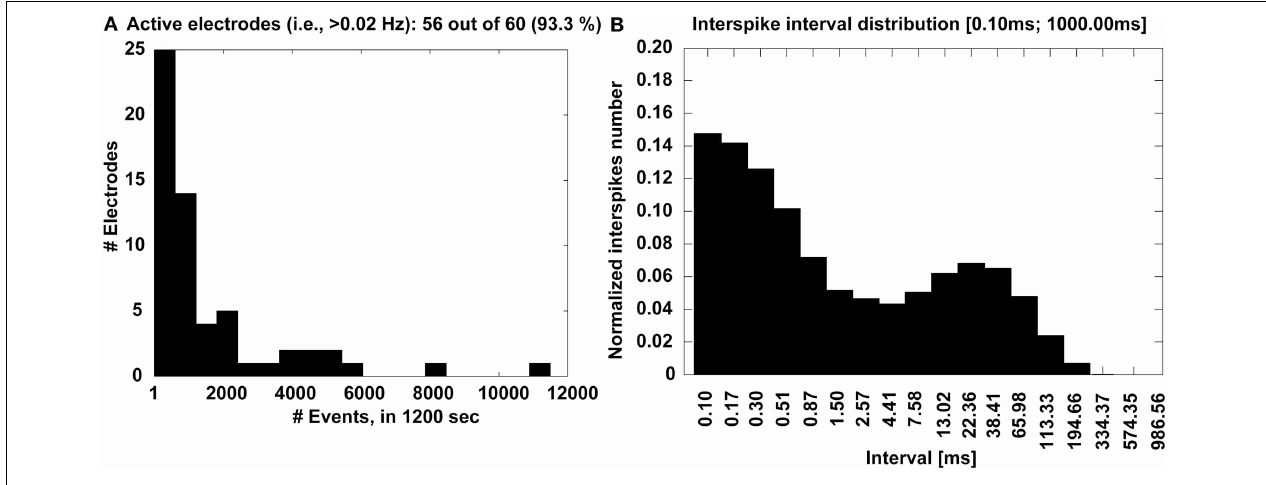
FIGURE 7 | Experimental outcome at a glance. The distribution of the number of electrodes (A) that detected activity with significant occurrence frequency is displayed, together with the MEA-wide